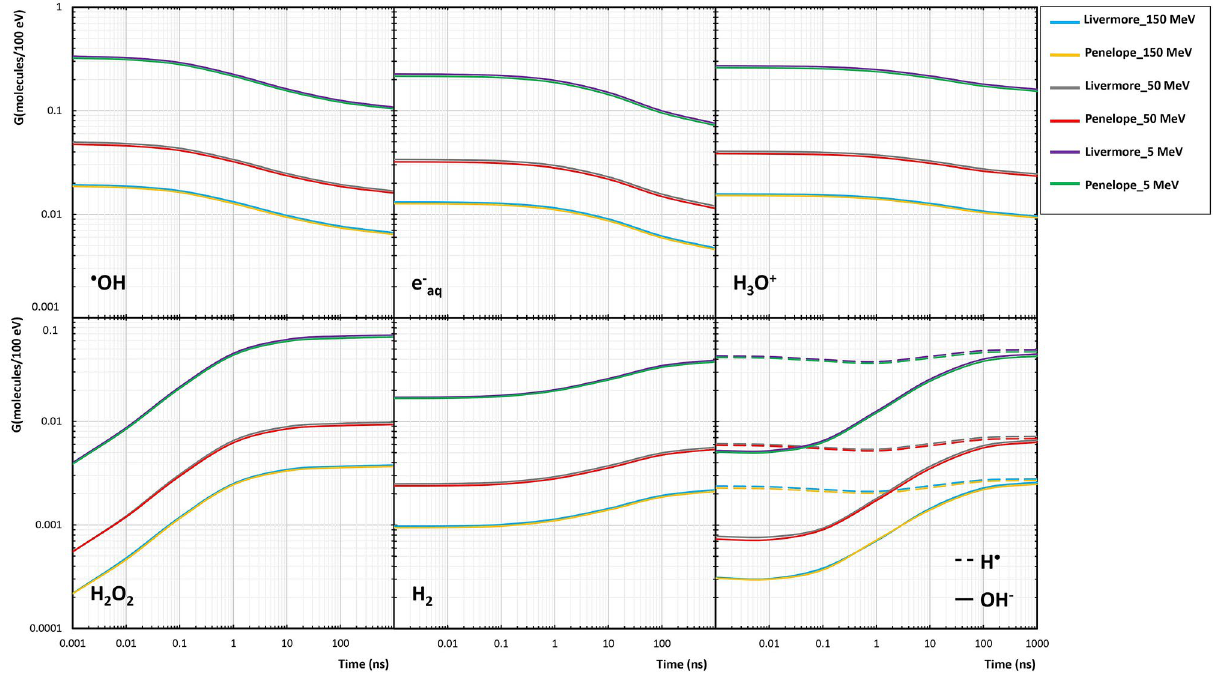
Figure 7. Comparison of the G-value (molecules/100 eV) between the Livermore and Penelope models obtained for 5, 50, 150-MeV proton beams as a function of